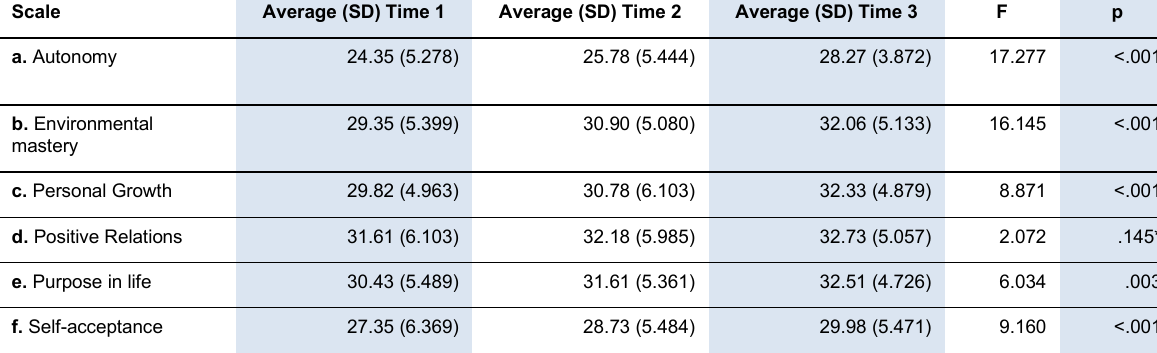
Table 2: Repeated measures ANOVA